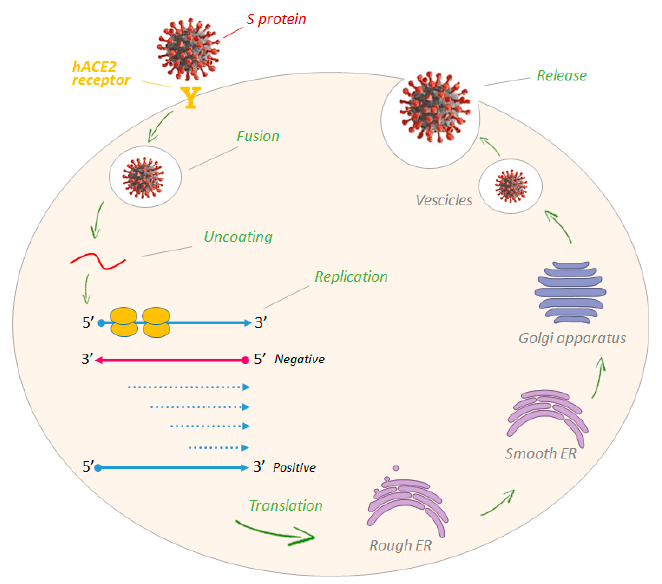
Figure 4. Viral replication scheme.